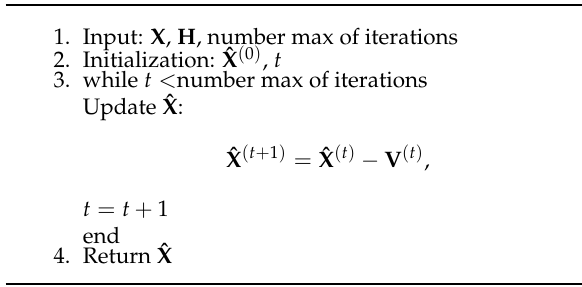
Table 1. The problem described in four